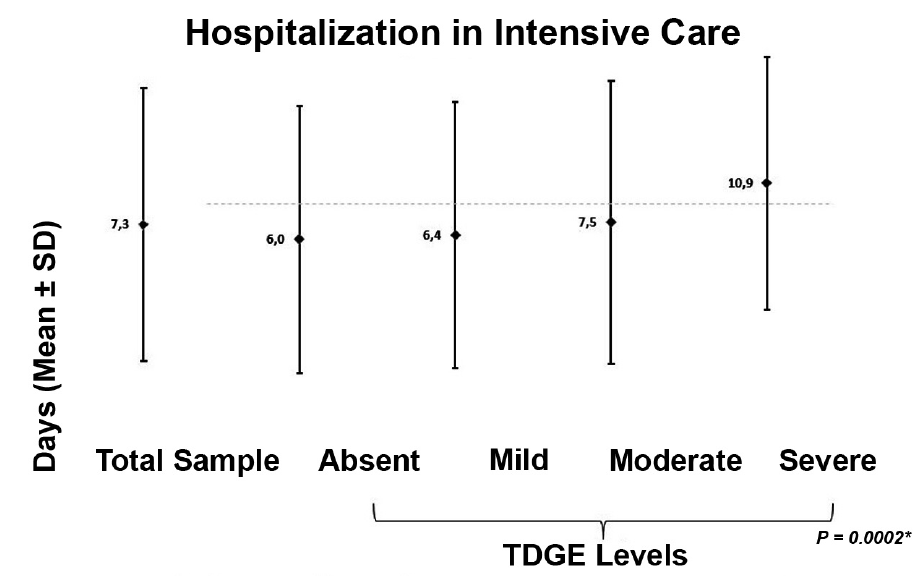
Fig. 1- The average length of stay in the Intensive Care Unit. TDGE=transient dysfunction of gas exchange; TDGE absent=PaO FiO between 200 mmHg and 300 mmHg; TDGE moderate=PaO 2 severe TDGE=PaO /FiO <100 mmHg; * P-value=* ANOVA followed by transformation with posts by 2 2 Tukey’s test. TDGE Record significantly proved superior to other levels of TDGE regarding Apache II score.